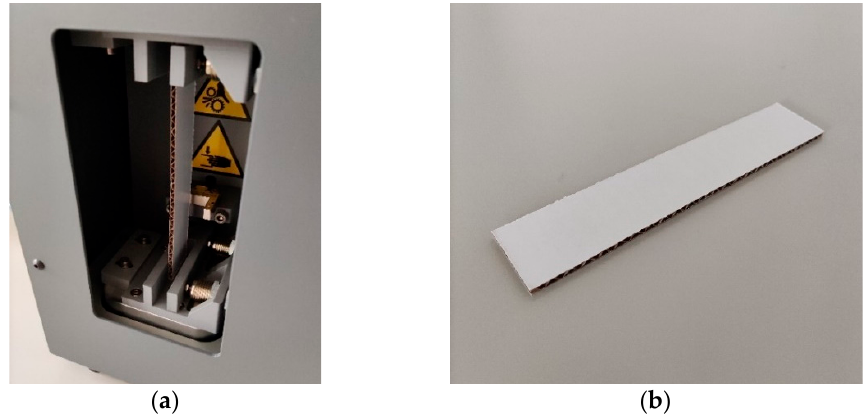
Figure 3. Torsion stiffness test: ( a ) the testing socket and ( b ) the corrugated board sample.